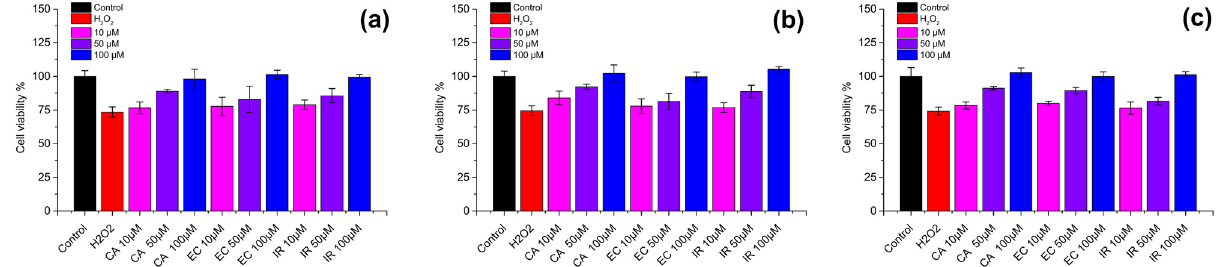
Figure 6: E ff ects of chlorogenic acid ( CA ) , echinacoside ( EC ) , and isorhamnetin - rutinoside ( IR ) on cell viability of hydrogen peroxide induced ( a ) LO2, ( b ) GES - 1, and ( c ) HUVEC